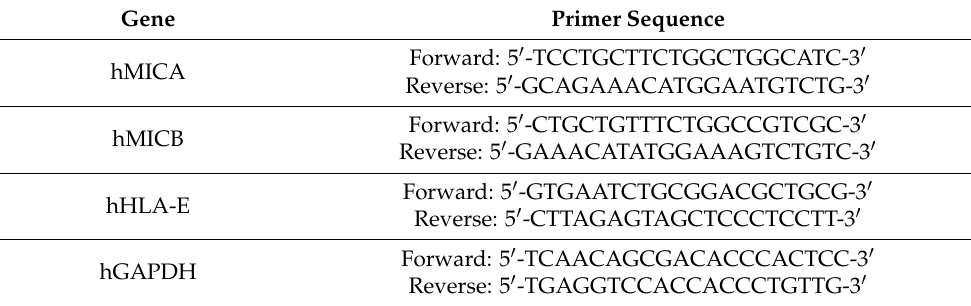
Table 1. Sequences of primers used in the